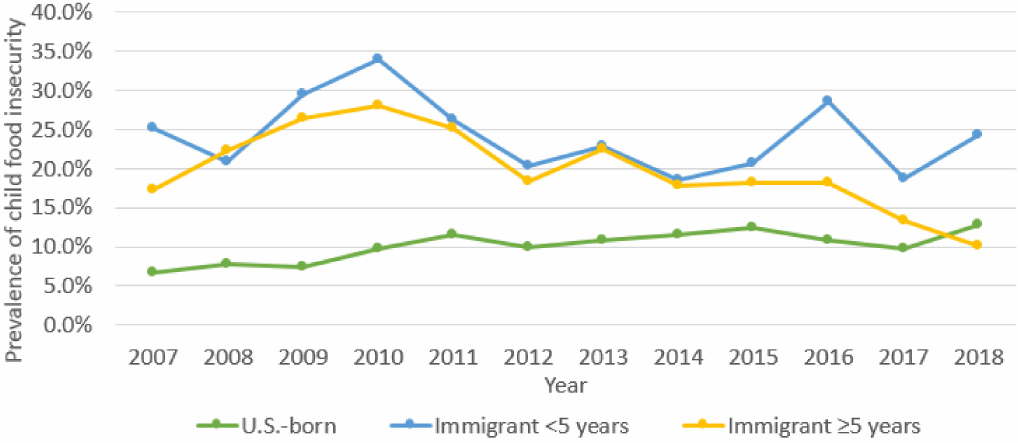
Figure 3. Trends in child food insecurity 2007–2018 by mother’s place of birth.